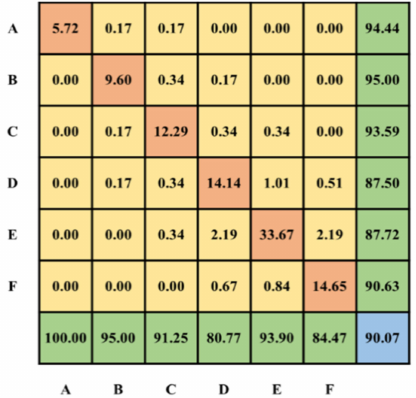
Figure 18. Confusion matrix of the CNN